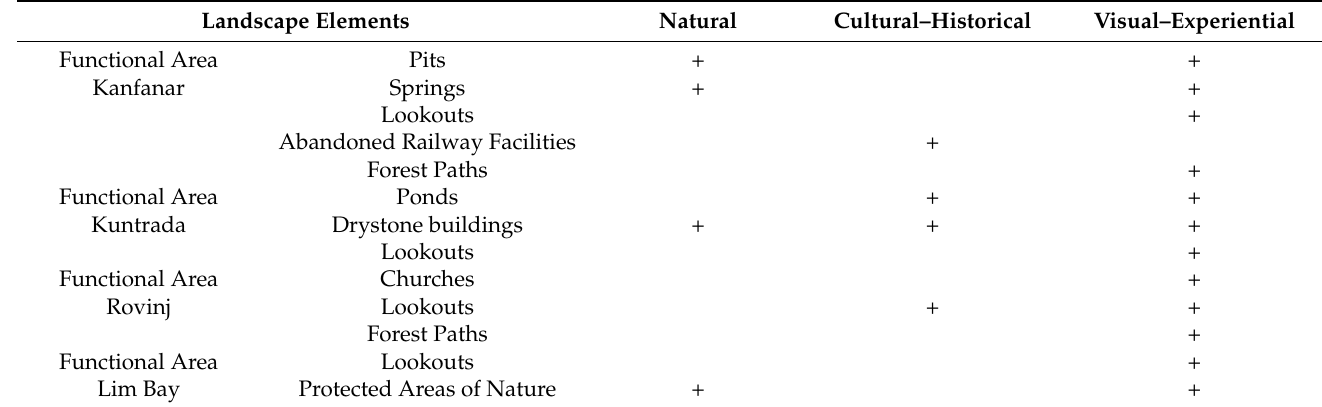
Table 4. An overview of functional areas with selected contents and their